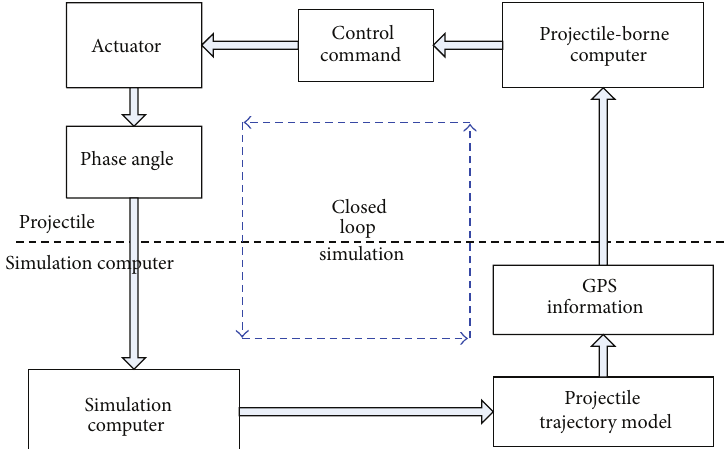
Figure 25: Block diagram of hardware in the loop simulation system working principle.